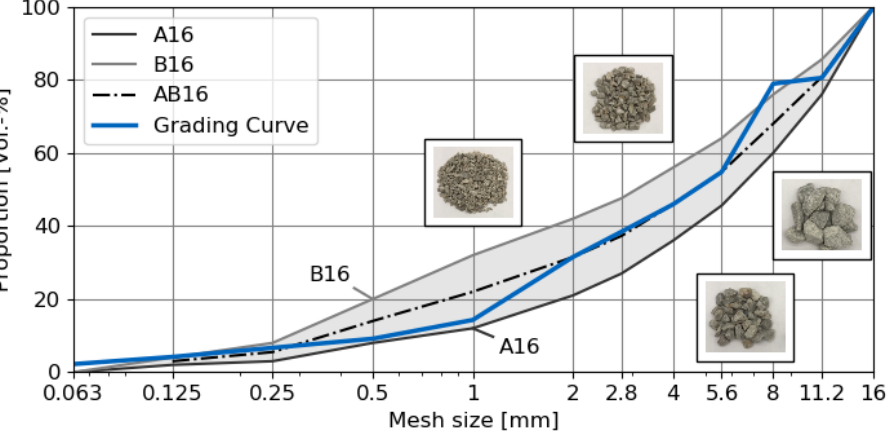
Figure 1. Standardised and optimised aggregate distributions for a concrete mix with an approxi- mated AB16 aggregate distribution.